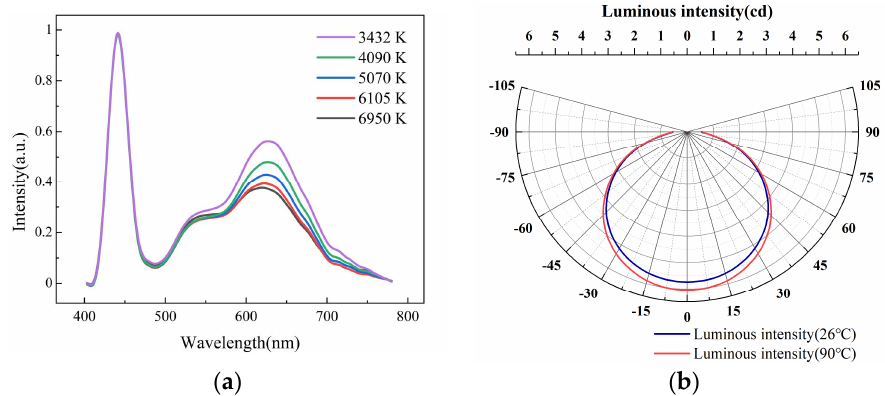
Figure 6. ( a ) Electroluminescence spectra of white lights with different CCTs. ( b ) Light distribu- tion curves of LEDs.